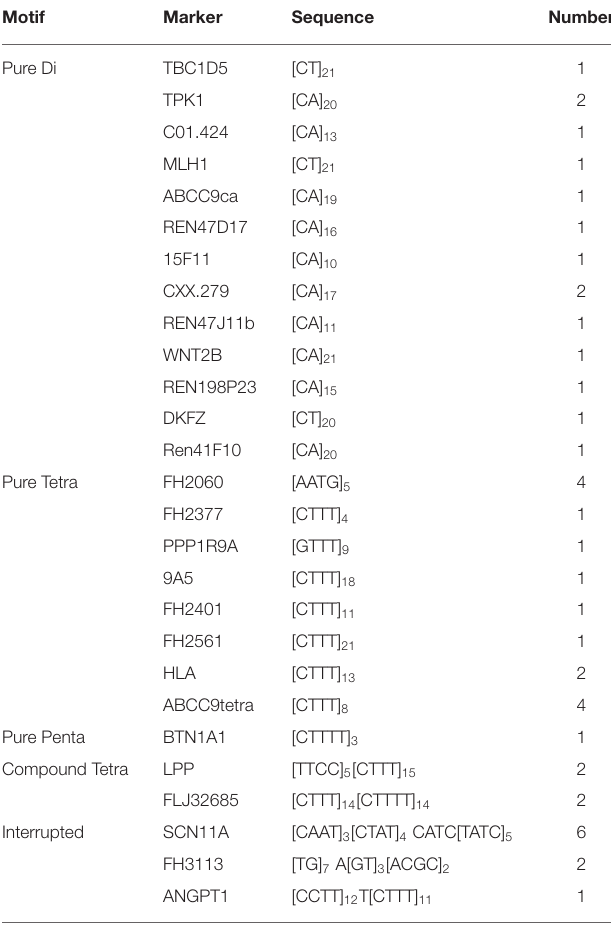
TABLE 4 | Frequency of ABCC9tetra, FH2060, and SCN11A in MS mutation